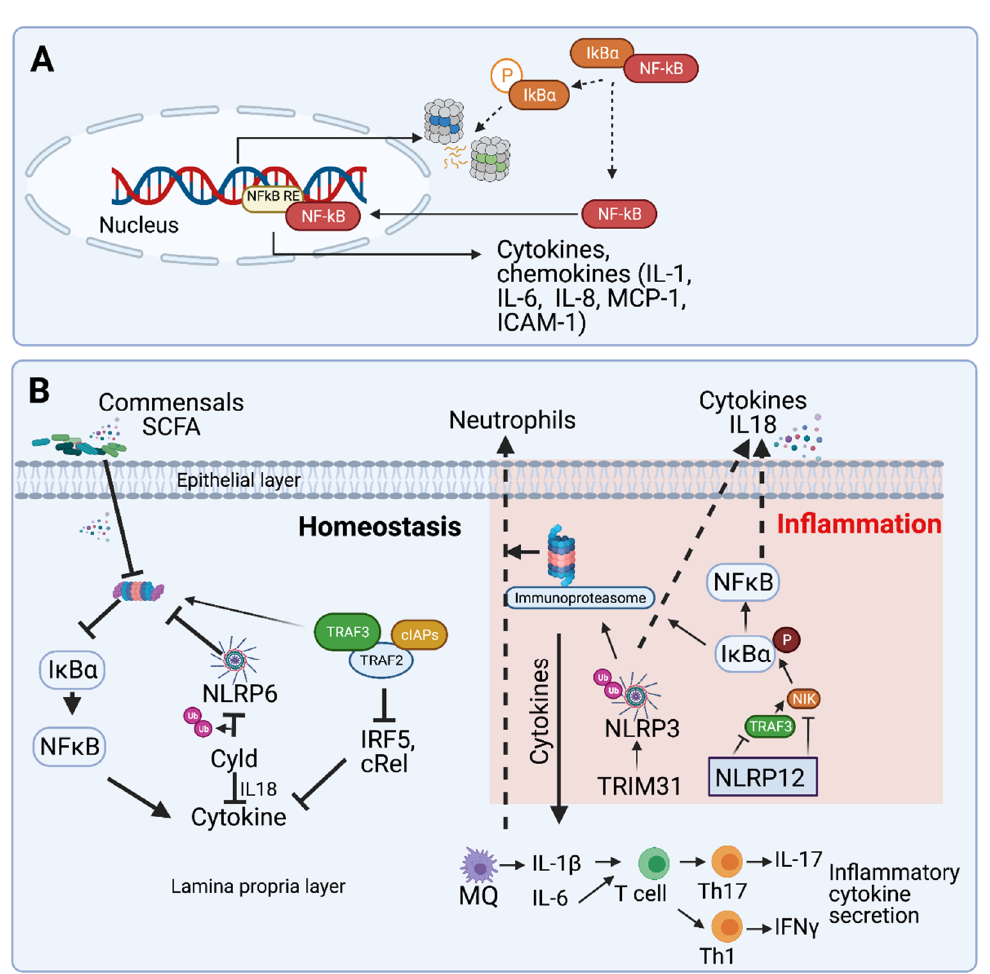
Figure 2. ( A ) Proteasome-dependent NFκB signaling: Under steady state, NFκB is kept inactive by association with IκB. Inflammatory signals induce the phosphorylation of IκB, its dissociation from NFκB, and degradation by the proteasome. Upon the release from IκB, NFκB translocates to the nucleus, leading to transactivation of inflammatory cytokines, chemokines (IL-6, IL-8, IL-1, etc.), and apoptotic genes (ICAM-1, Bcl) [23]. ( B ) Proteasomes at the crossroad between gastrointestinal homeostasis and inflammation: Various proteasomal degradation events restrict constitutive inflammation and maintain homeostasis. Metabolites secreted by commensals such as L. casei block proteasome activation, which in turn leads to reduction in IκB degradation, thereby hindering NFκB activation [47]. Cyld, a deubiquitinating enzyme, deubiquitinates NLRP6, prevents NLRP6 degradation, and enhances release of IL-18 [48]. The TRAF2/3 complex activates cRel and IRF5 that induce pro-inflammatory cytokines in response to danger stimuli. The E3 ligase cIAP is recruited to the TRAF2/3 complex, leading to the degradation of both TRAF2 and TRAF3, thereby limiting production of inflammatory cytokines [49].